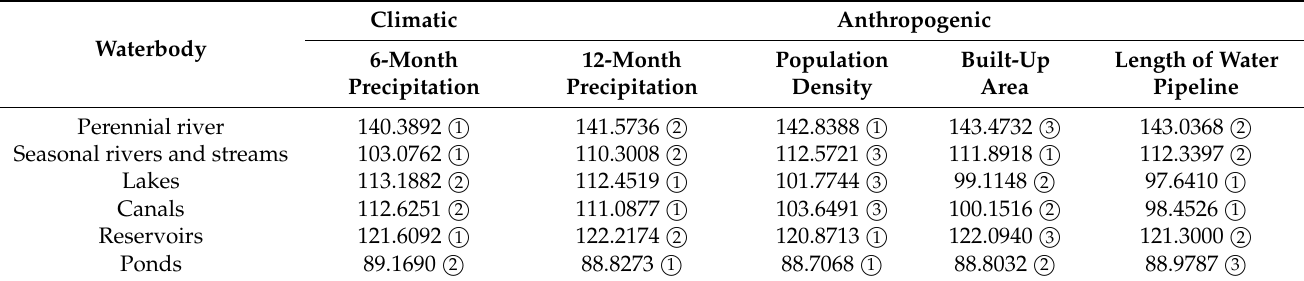
Table 4. Selection of the most predictive climatic and anthropogenic variables for the total surface area of each waterbody type. Corrected Akaike Information Criterion (AICc) values are shown in the table and were used to select the predictor variables for the linear regression models shown in Table 5. The variables with the lowest AICc are indicated by ① ② ③.